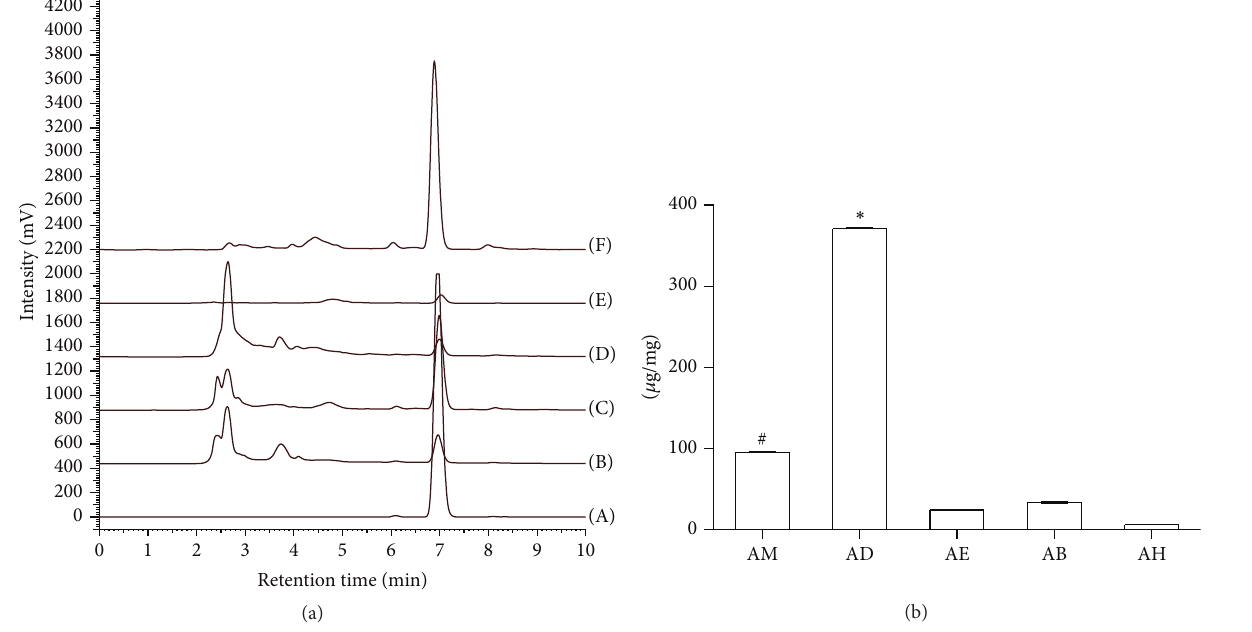
Figure 1: The artocarpin content of A. communis extract and fractions was determined by HPLC-UV with a Lichro-CART 250-4 Purospher STARRP-18ecolumn.(a)HPLCchromatogramof(A)Art100 𝜇 g/mL,(B)AB1 𝜇 g/mg,(C)AM1 𝜇 g/mg,(D)AE1 𝜇 g/mg,(E)AH1 𝜇 g/mg,and (F) AD 0.5 𝜇 g/mg. (b) Artocarpin content of A. communis methanol extract and its fractions. Values are expressed as mean ± SD, 𝑛 = 3 .